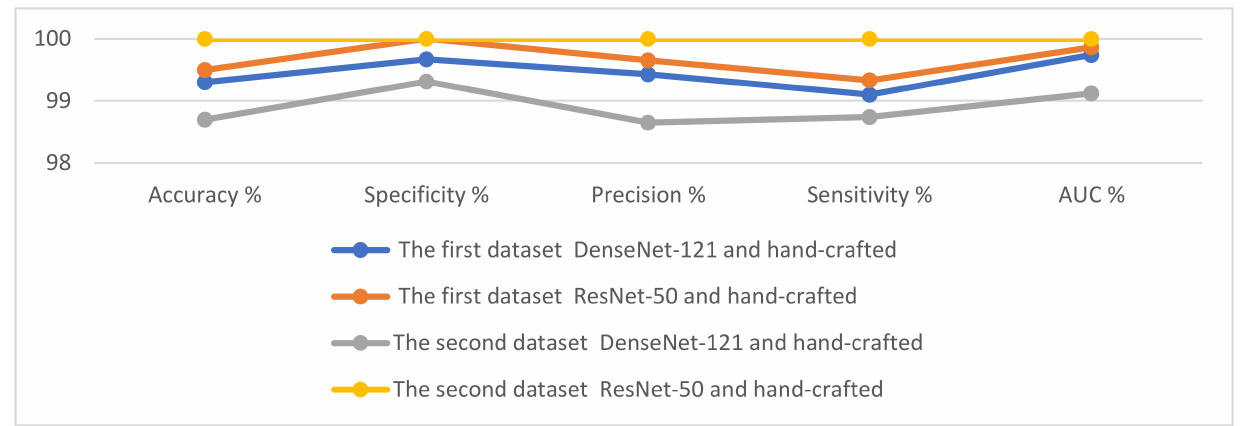
Figure 14. The demonstration of the FFNN performance with the hybrid features in the detection of malignant